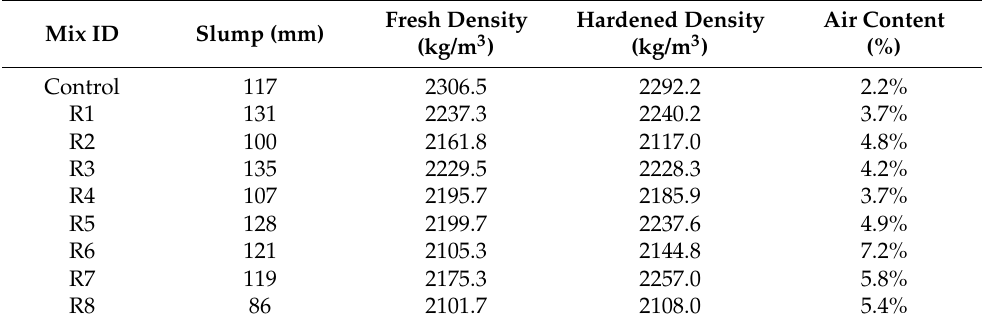
Table 2. Physical properties of fresh concrete and hardened density at 28